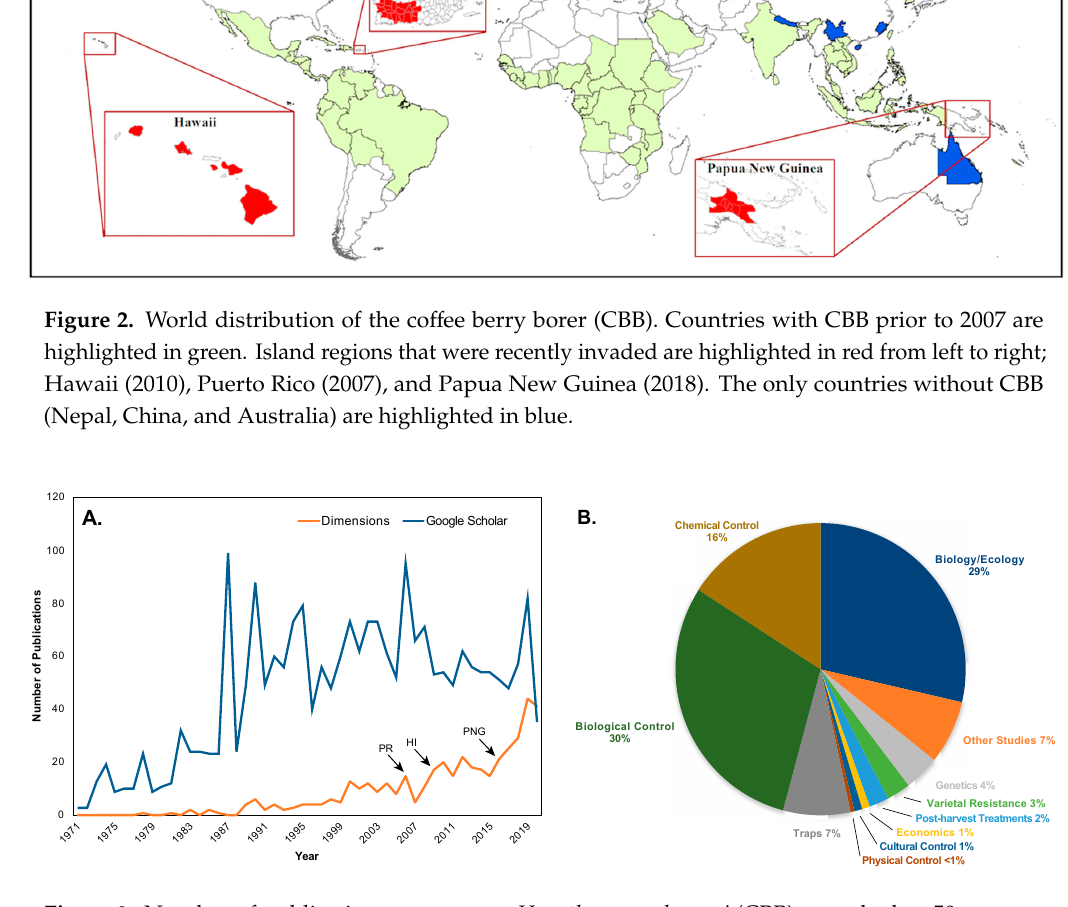
Figure 3. Number of publications per year on Hypothenemus hampei (CBB) over the last 50 years as reported in the Dimensions and Google Scholar databases ( A ). The arrows indicate when CBB was introduced to Puerto Rico (PR), Hawaii (HI), and Papua New Guinea (PNG). Over the last 10 years (2011–2020), the majority of publications have been focused on describing the basic biology and ecology of CBB, and investigating biological and chemical controls ( B ).